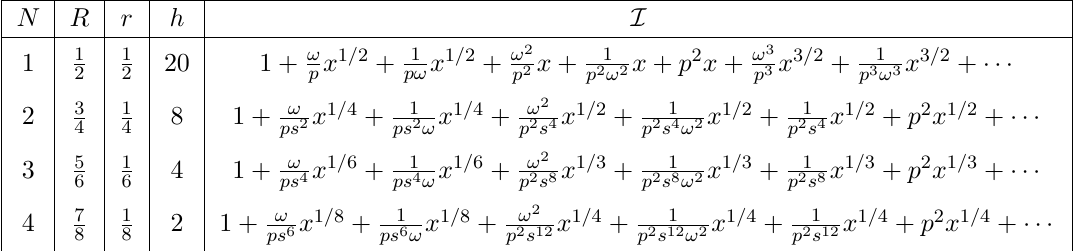
Table 3 . Computation of the superconformal index for di(cid:11)erent values of N up to order O In the last column we report the (cid:12)rst terms of the